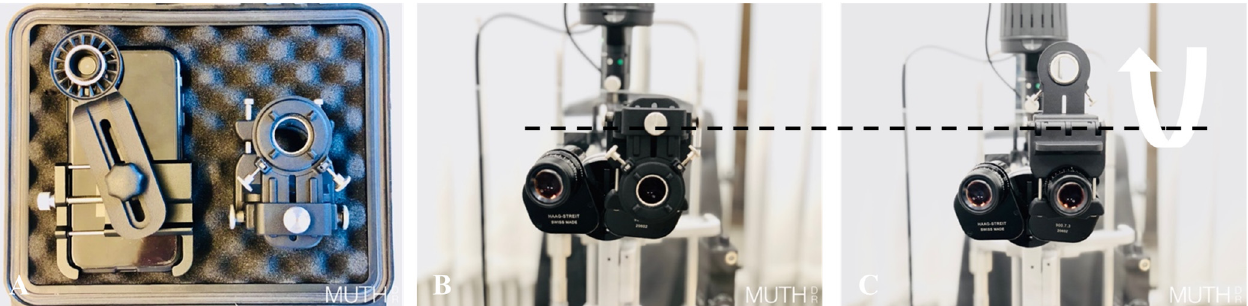
Figure 1. Custom Surgical SlitREC adapter: ( A ) smartphone adapter (left) and eyepiece adapter (right). ( B ) Eyepiece adapter mounted on a slit lamp via two hex socket screws ( Allen / Inbus screws). The other two screws can be used optionally to hold the smartphone adapter. In our setting, the magnetic ring alone proved to be strong enough. ( C ) Eyepiece adapter flipped up to allow binocular use of the slit lamp.